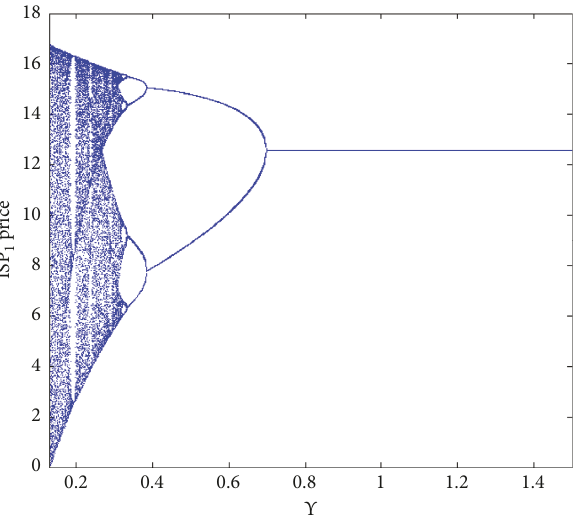
Figure 14: Bifurcation diagrams of p